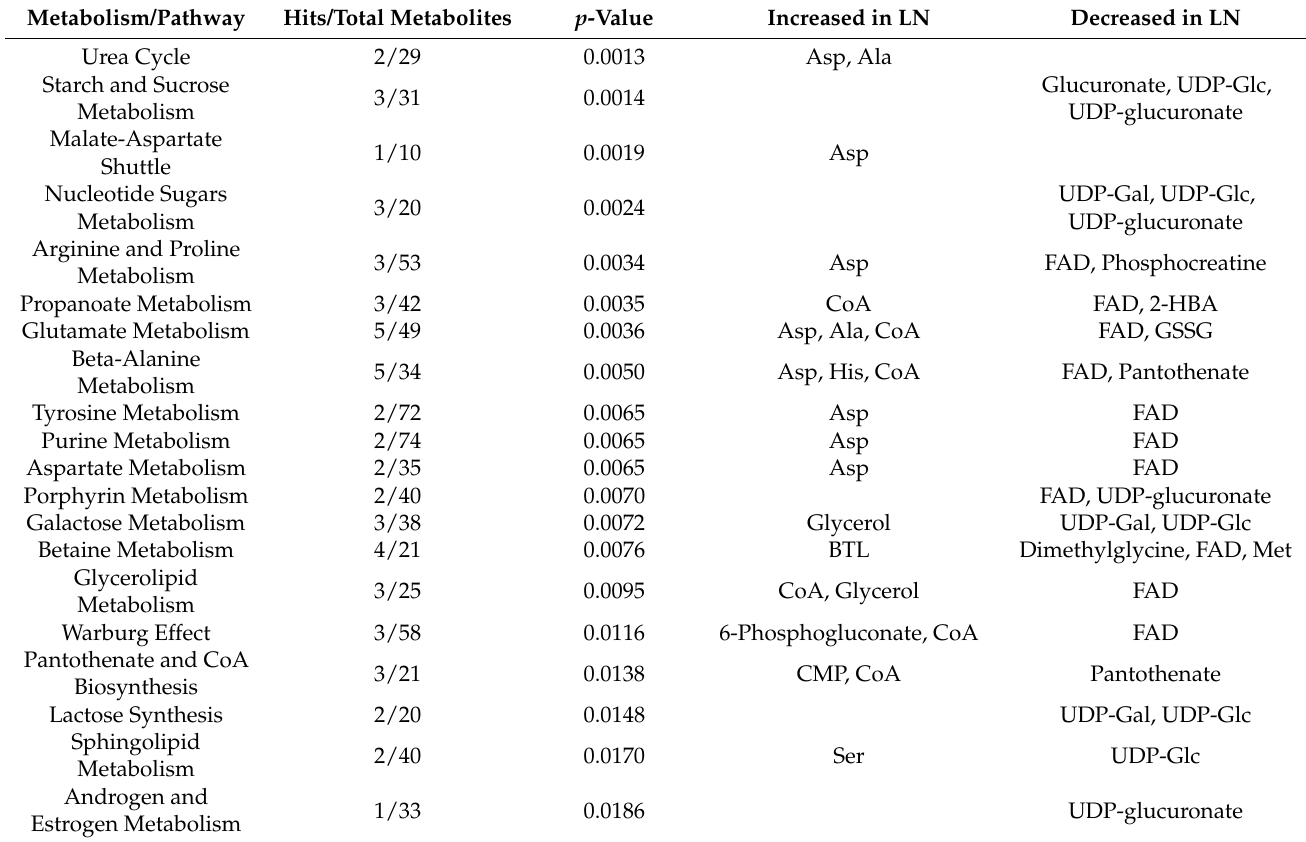
Table 3. Top 20 fetal liver metabolisms different between LN and HN fetuses